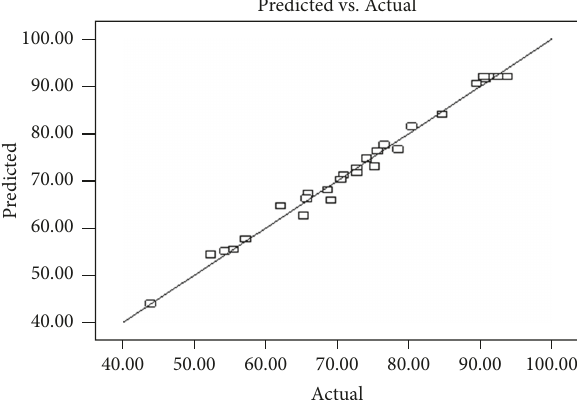
Figure 2: Plots of actual response versus predicted response.